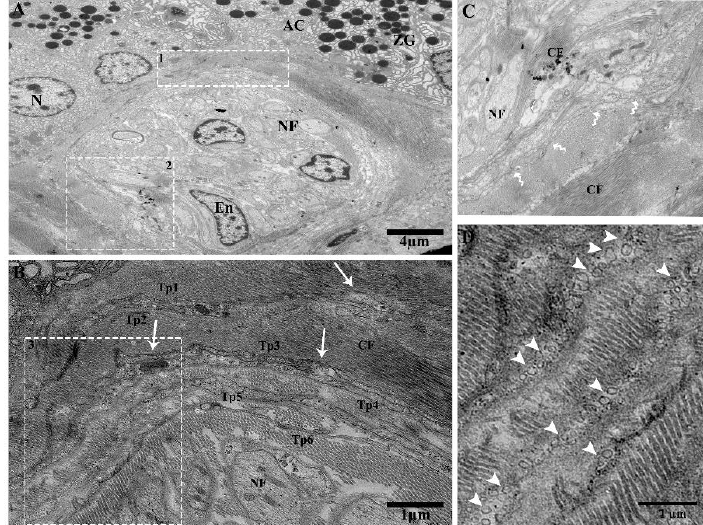
Figure 7. Large duct attached with lobules through the connective tissue in between the gland cells. Tps surround the ductus and form triangular structures and shading vesicles in the connective tissue. ( A ) Telopodes establishing a triangular structure “trio” adjacent to the acinar cells and collagen fibers, nerve fibers, and telopodes showing nano-contacts. Square-marked areas 1 and 2 in ( A ) are enlarged in ( B , C ) respectively. ( B ) Tp 1 , Tp 2 , Tp 3 , and Tp 4 have gap junctions, and there are close connections between Tp 5 and Tp 6 . The podoms contain mitochondria and caveolae (white arrows). ( C ) In the vicinity of collagen fibers, nerve fiber Tps junctions (podoms – podoms) and segments (bent arrows) can be seen. The square-marked area 3 in ( B ) is enlarged in ( D ), where numerous shading vesicles (arrowheads) in the connective tissue, along with collagen fibers, at the ending point of Tp 1 , Tp 2 , Tp 3 , Tp 4 , Tp 5 , and Tp 6 are often captured, which suggests a transfer of information between telopodes and adjacent cells. Tp, telopodes; CF, collagen fibers; NF, nerve fiber; En, endothelial cells; AC, acinus; ZG, zymogen granules. Scale bar =4 µm in ( A ); scale bar = 1 µm in ( B , D ).